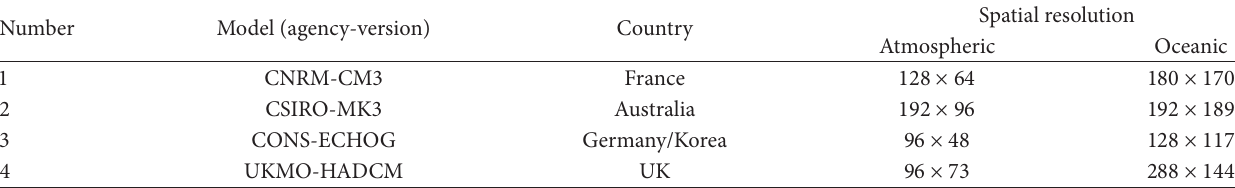
Table 3: Detailed information on the four GCMs used in this